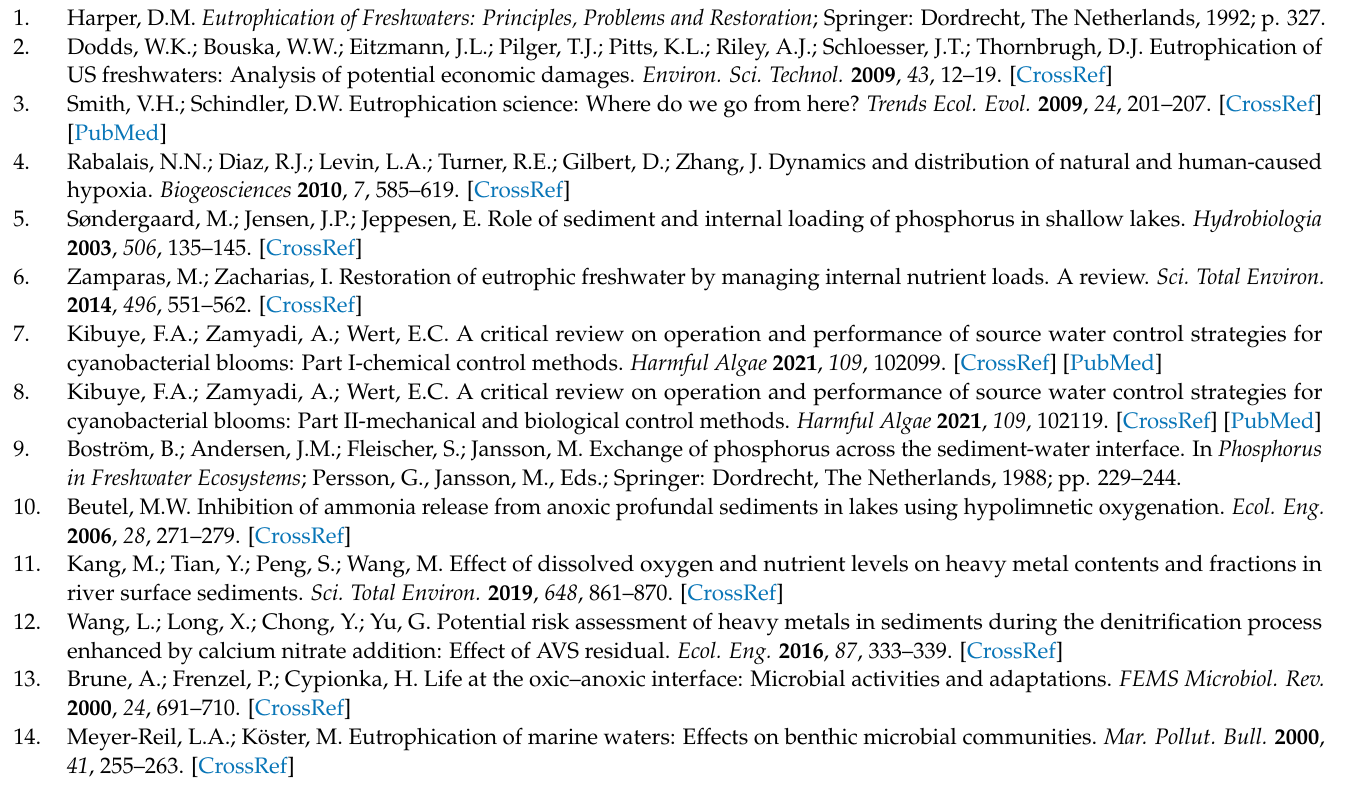
Figure A2. Diversity indices of the bacterial community in water and sediment samples.